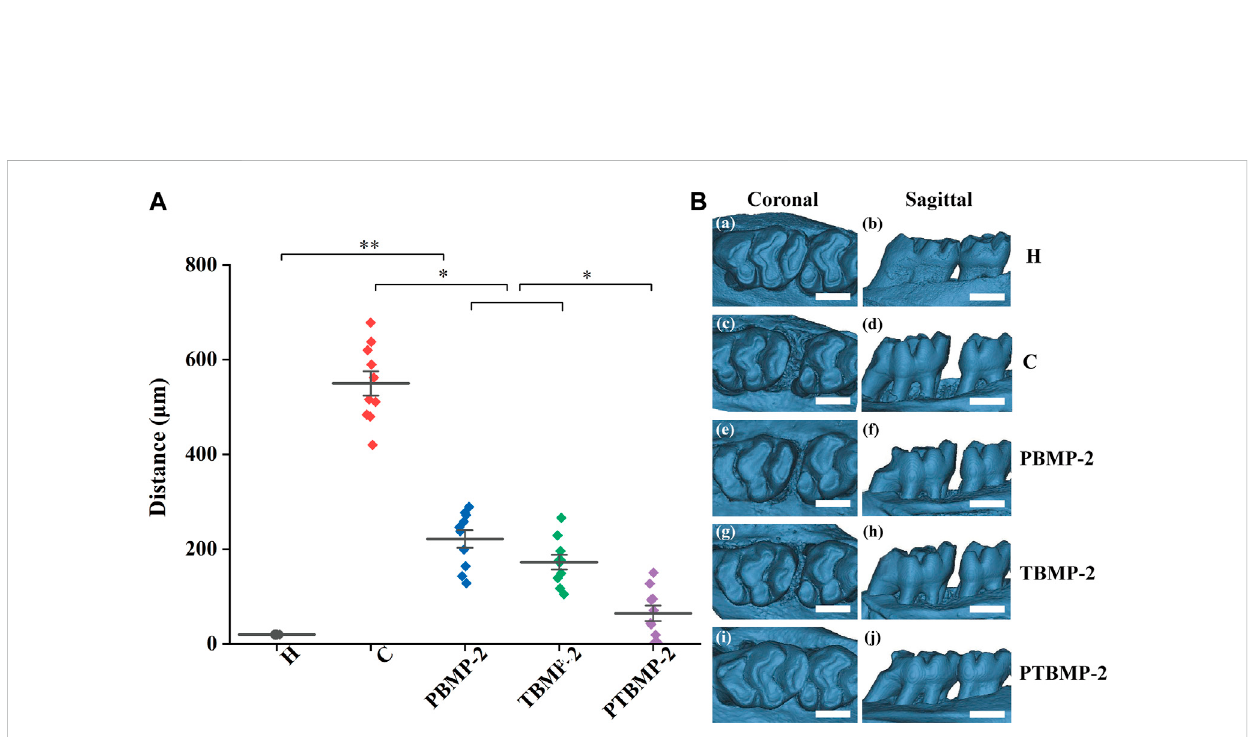
FIGURE 4 Mean and standard deviation of tooth movement ( μ m) measured by the horizontal distance between the highest convexity on the distal surface of fi rstmolarsandthehighestconvexityonthemesialsurfaceofsecondmolars (A) .Representativethree-dimensionalconstructivemicro-CTviewsimages showing tooth moving distance (B) , scale bar = 1,000 μ m *Signi fi cant ( p < 0.05) difference between groups, **Signi fi cant ( p < 0.01) difference between